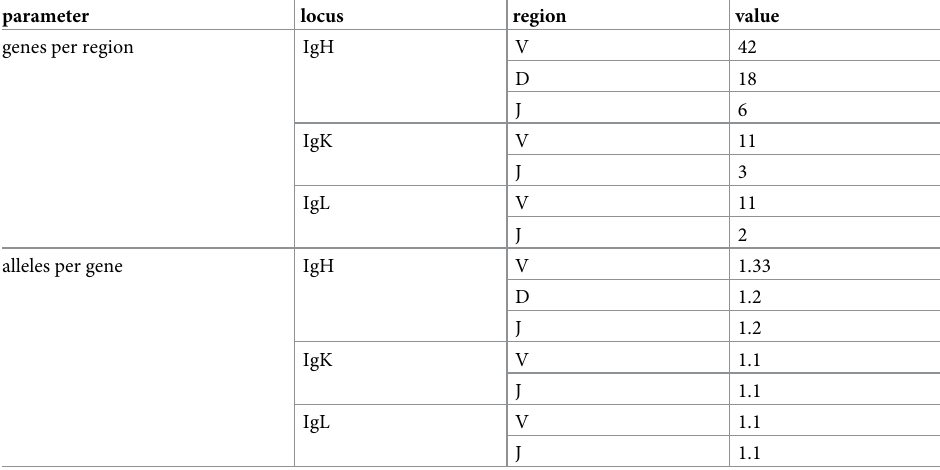
Table 1. Default values for simulation parameters controlling germline set generation when simulating from scratch.